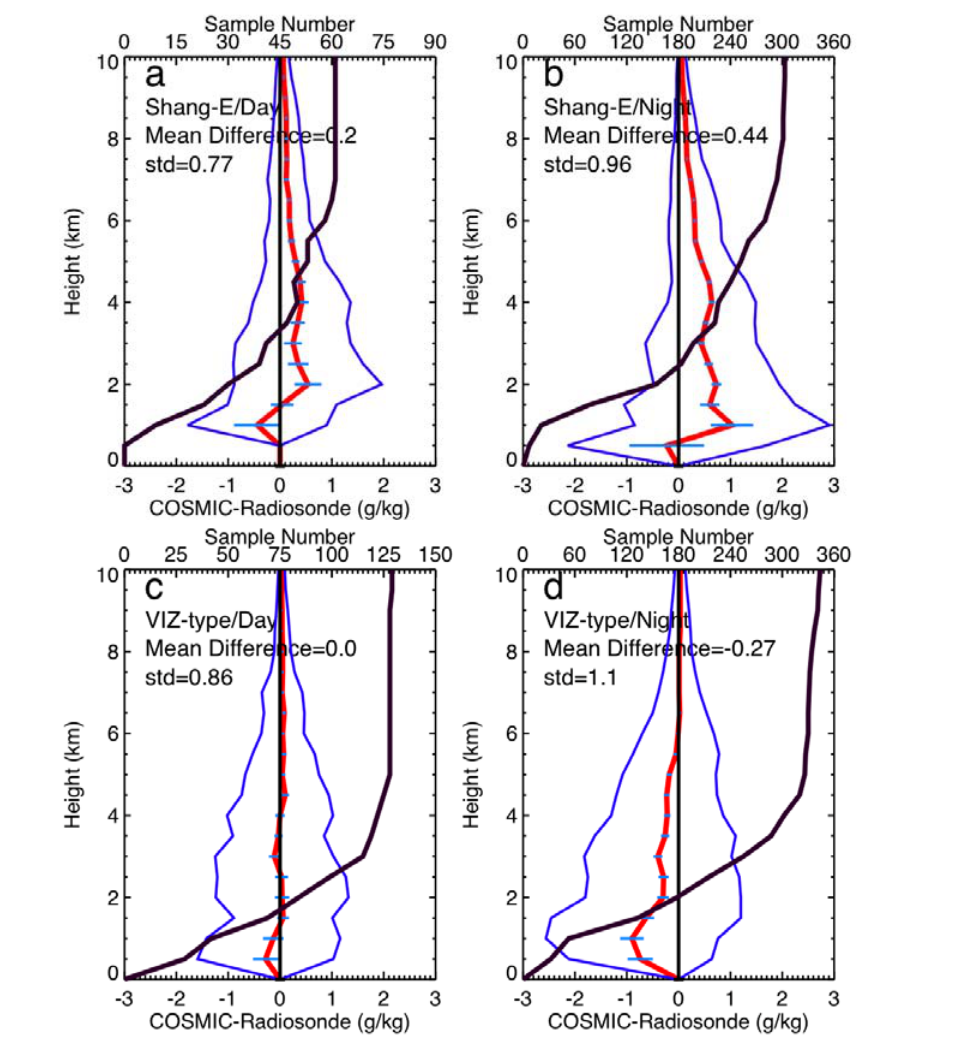
Figure 4. The same as Figure 3 except for (a) COSMIC-Shang-E pairs during the day, (b) COSMIC-Shang-E pairs during the night, (c) COSMIC-VIZ-type pairs during the day, and (d) COSMIC-VIZ-type pairs during the